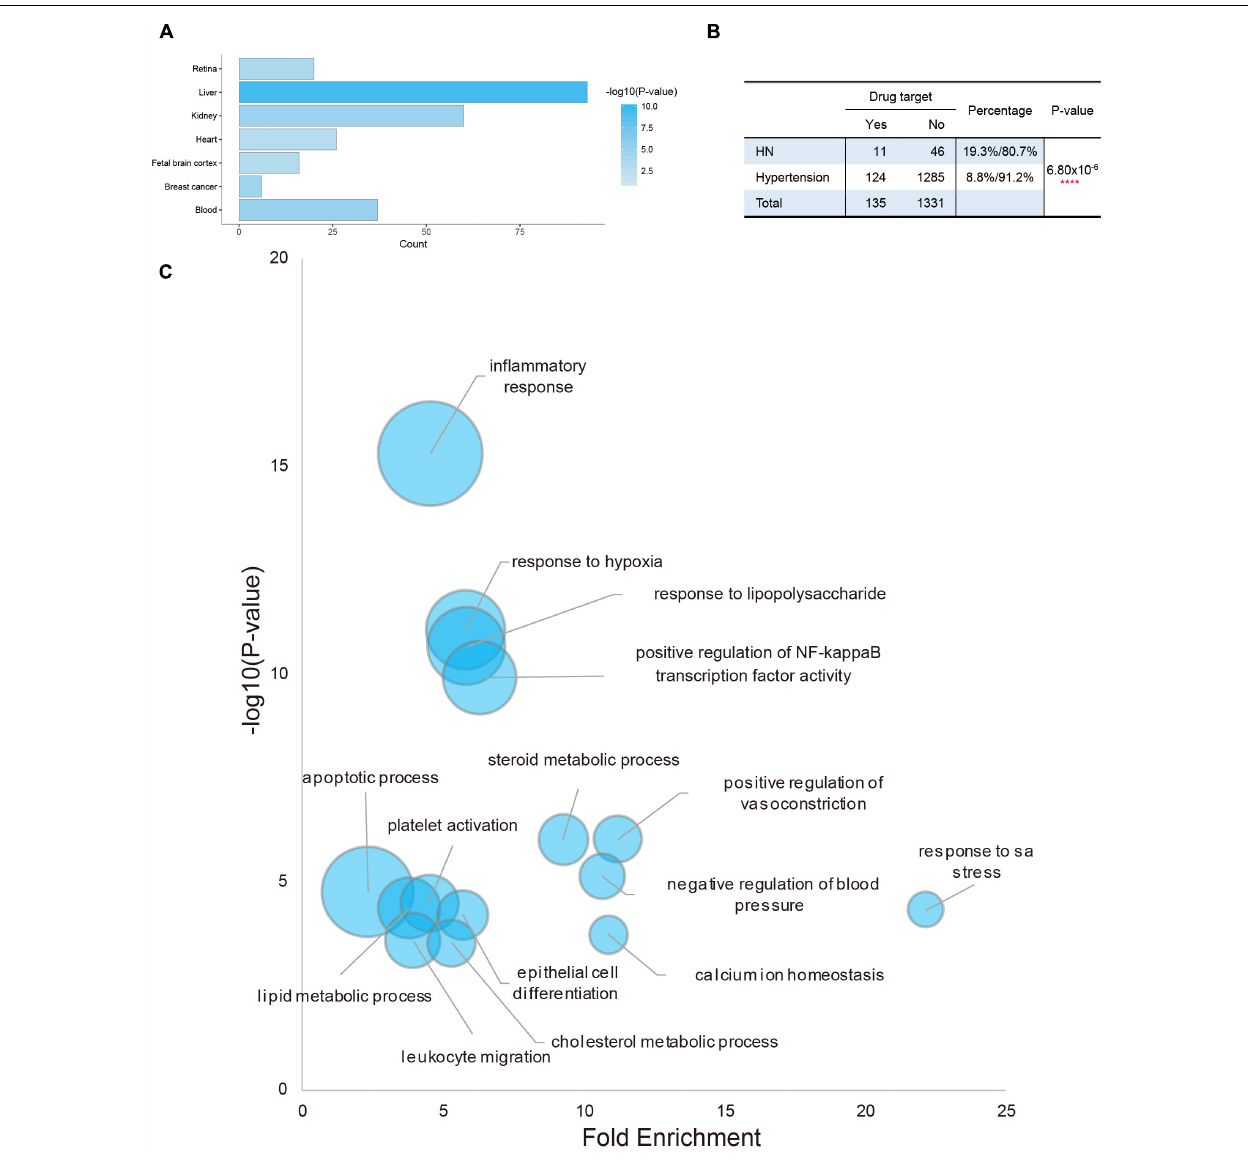
table for comparison of the distribution of QDZJN’s targets in disease gene of hypertension and HN. (C) Bubble diagram of enriched GO terms of QDZJN’s targets. X -axis is fold enrichment, Y -axis is related with p -value of enrichment analysis. Bubble size changes with the count of targets in this